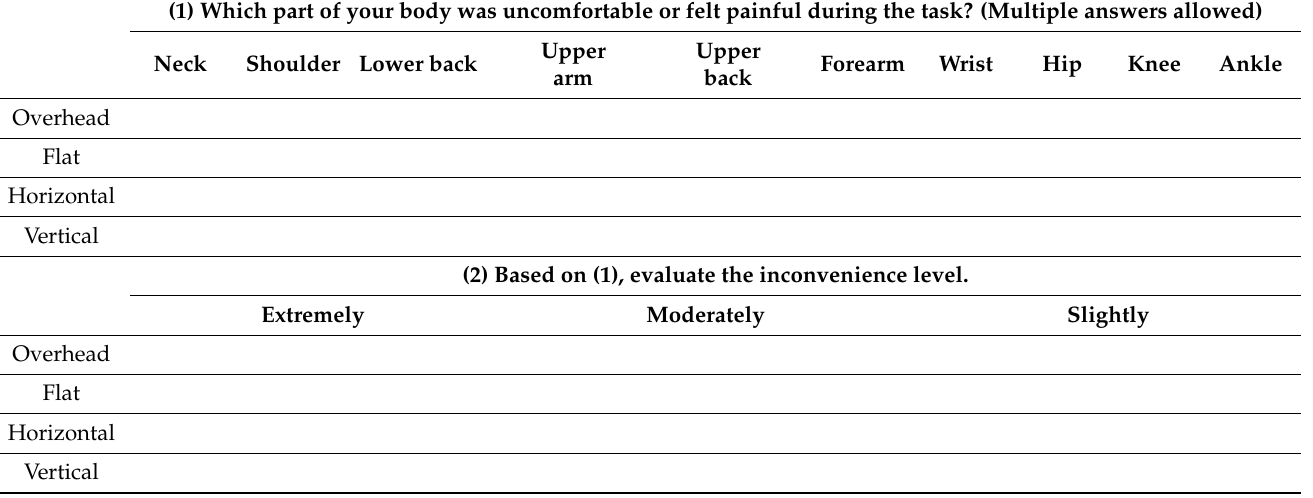
Table 1. Survey form of welding workload